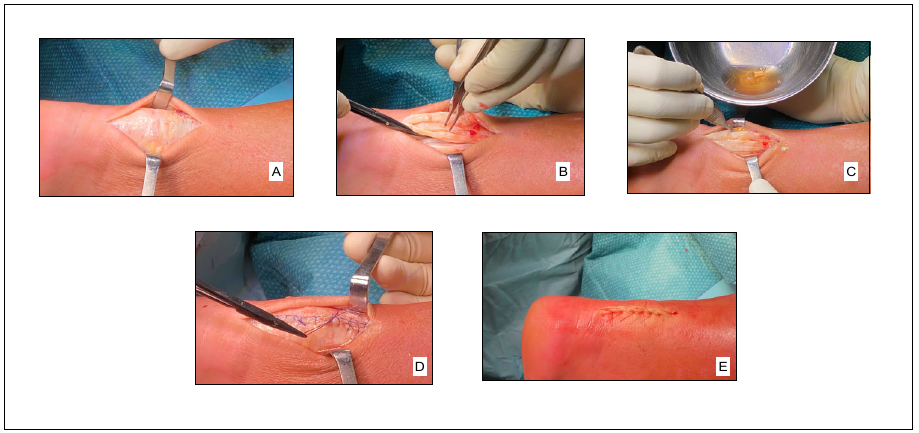
Figure 4. Surgical procedure: ( A ) access to the Achilles tendon; ( B ) debridement of the tendon midportion; ( C ) application of autologous PRFM; ( D ) suture of the fascia; ( E ) suture of the skin.